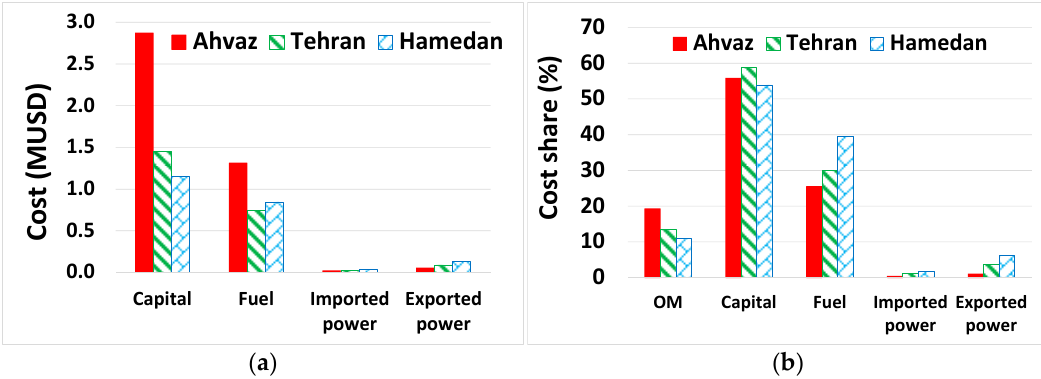
Figure 12. Total cost ( a ) and cost/income breakdown ( b ) for the polygeneration system in each city.